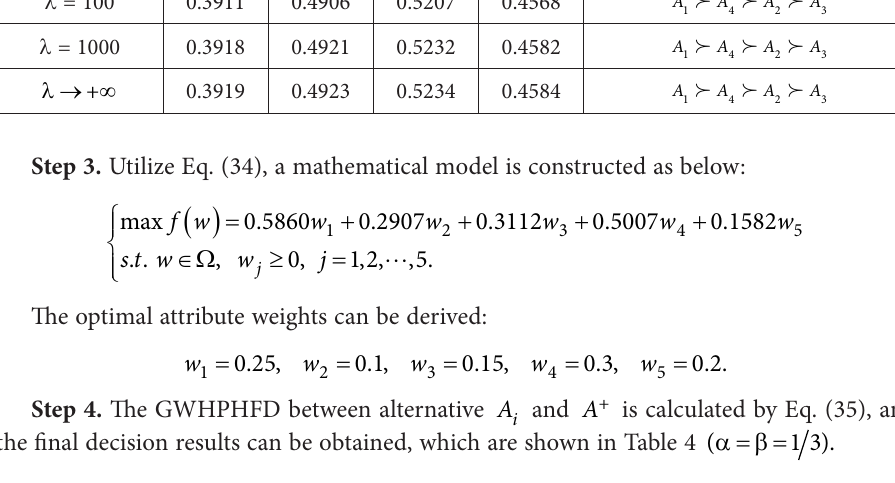
Table 4. The final decision results derived by the GWHPHFD A 1 A 4 Ranking